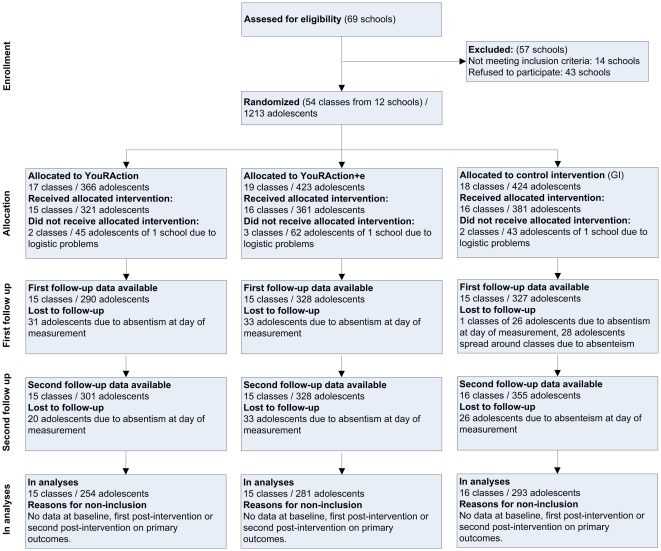
Flow diagram of the selection and enrolment of the study participants.